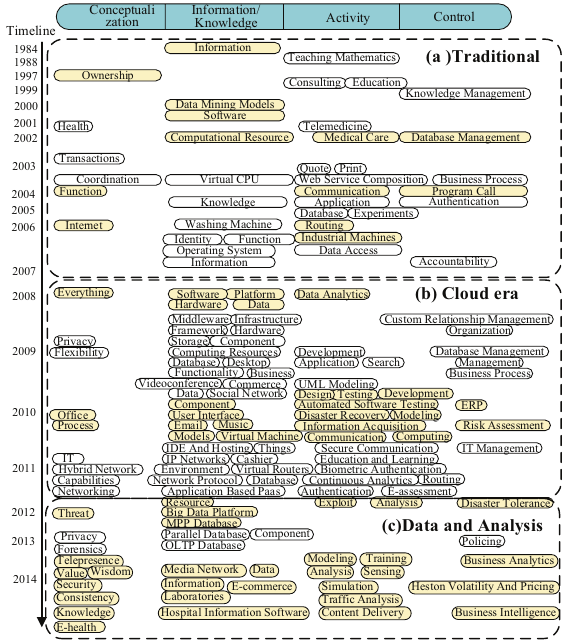
Fig. 3. The servicelization from concepts to the Cloud